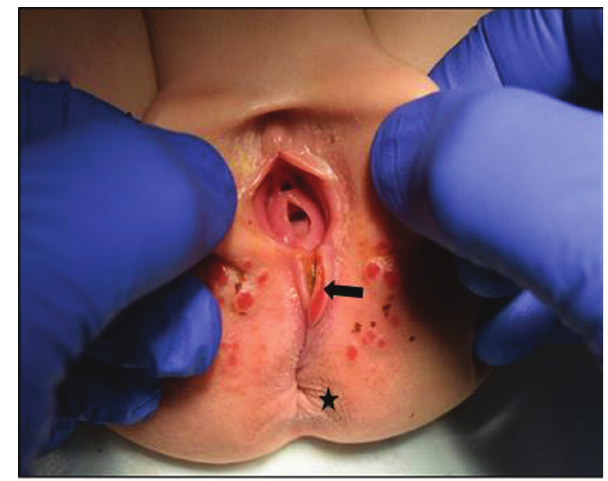
Fig. 1 Orthotopic and age-appropriate sized anus with surrounding sphincter (asterisk) and a perineal fi stula (arrow).